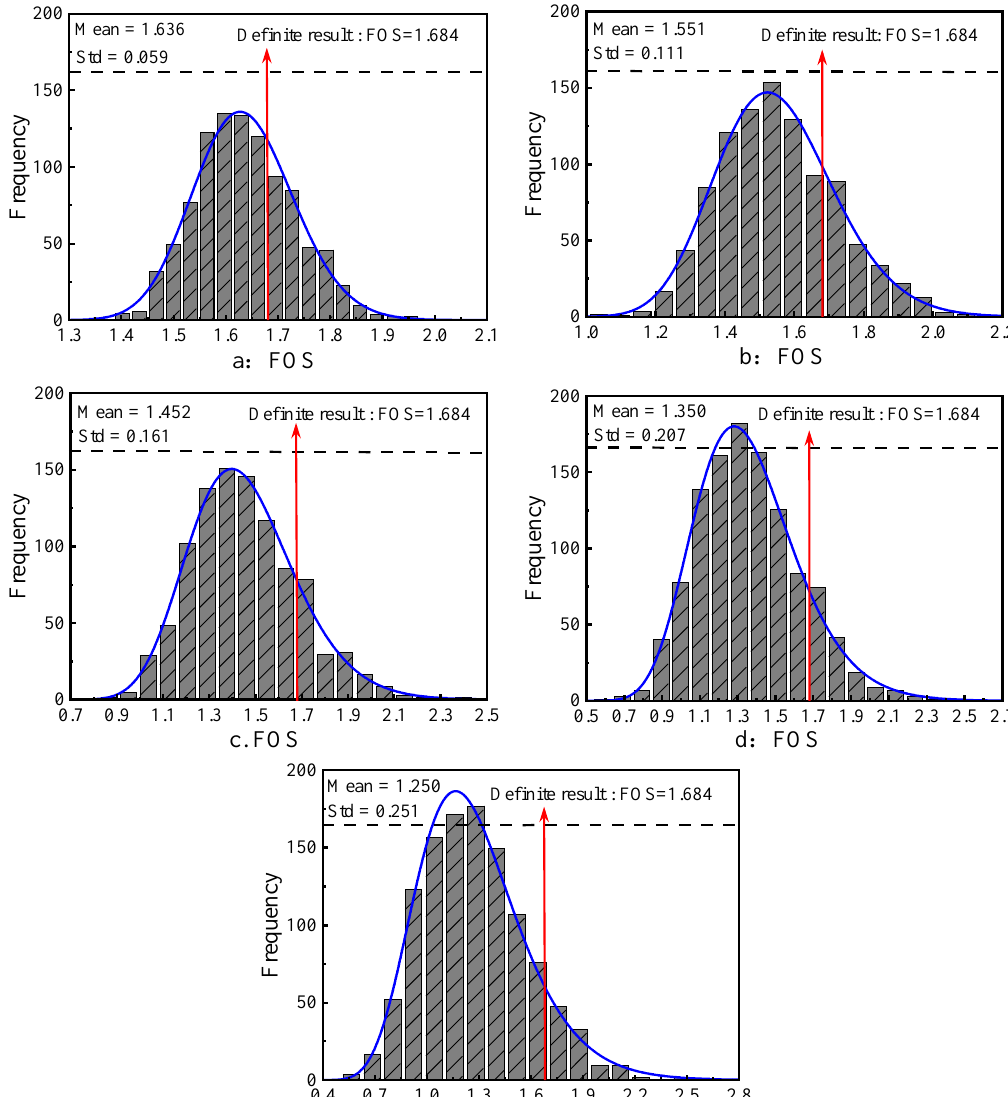
Figure 11. Histogram of the FOSs obtained from 1000 realizations for the set (WL = 5 m, l x = 50 m): ( a ) COV = 0.1; ( b ) COV = 0.2; ( c ) COV = 0.3; ( d ) COV = 0.4; ( e ) COV = 0.5.